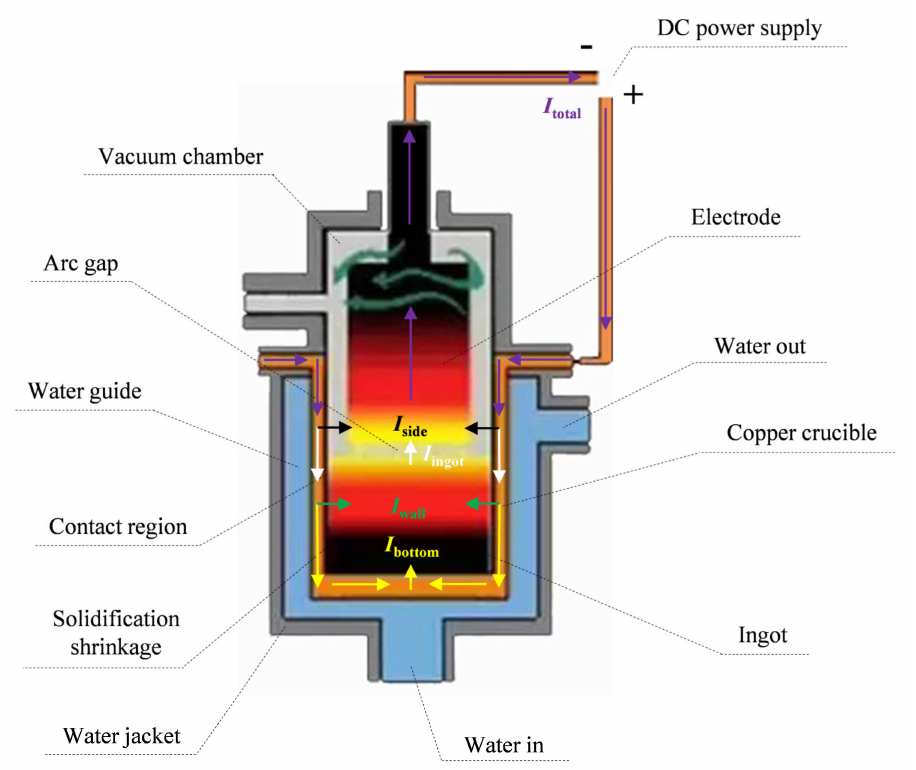
Figure 1. Schematic diagram of the VAR